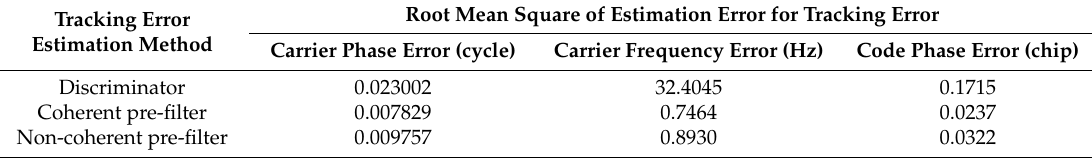
Figure 11. ( a ) The carrier phase error estimation in test scene A; ( b ) The code phase error estimation in test scene A. Table 2. Performance comparison of tracking error estimation methods in test scene A.